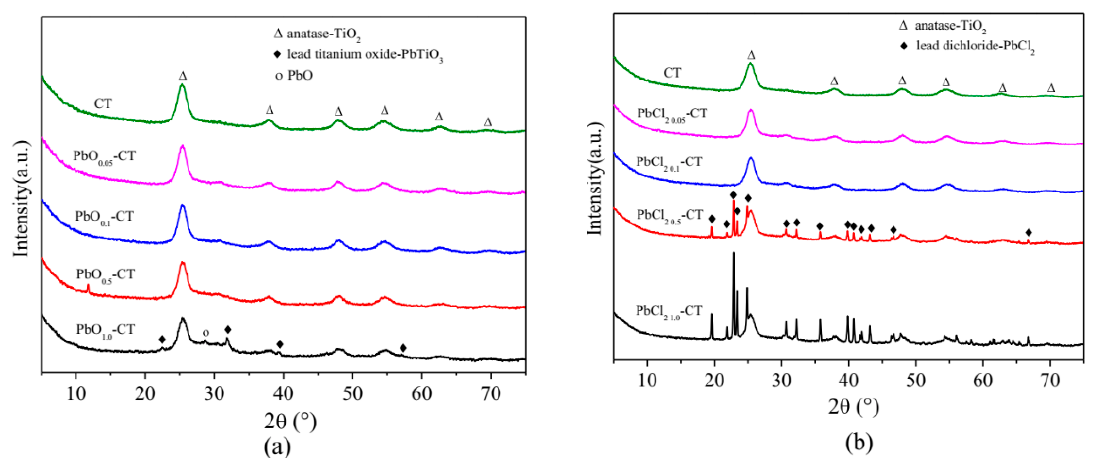
Figure 16. XRD patterns of PbO x -CT ( a ) and PbCl 2 x -CT ( b )